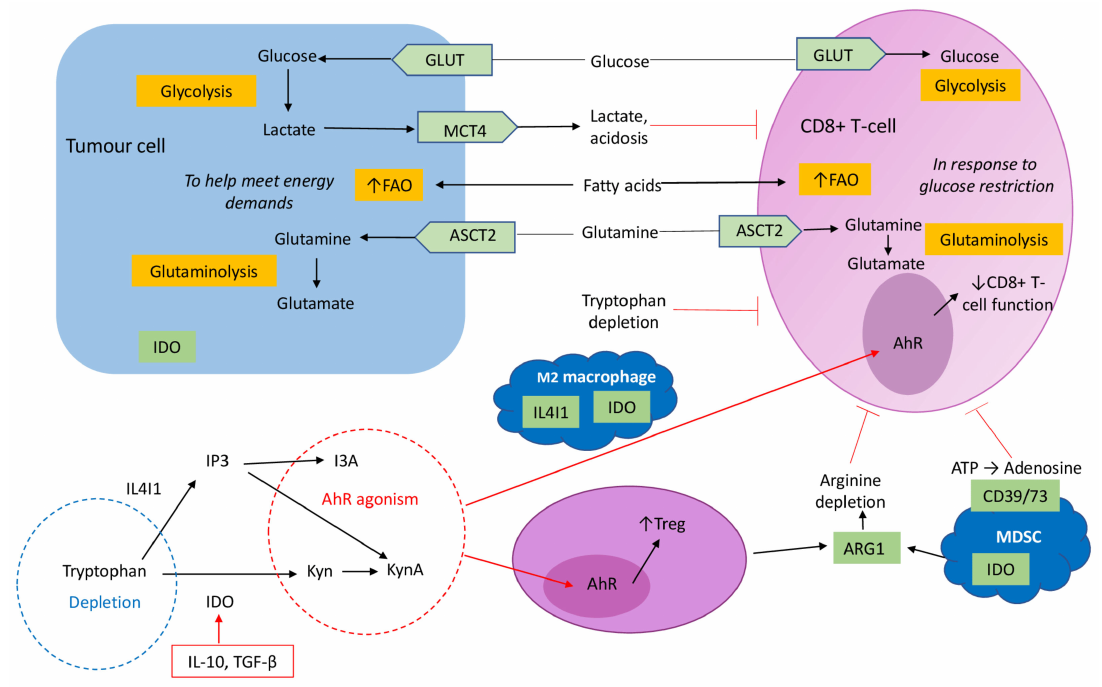
Figure 1. Effect of metabolic changes in the tumour microenvironment (TME) on immune cell differentiation. Increased tumour aerobic glycolysis, supported by upregulation of GLUT-mediated glucose provision provides energy for rapidly dividing cancer cells and leads to lactate accumulation within the TME. Fatty acid oxidation (FAO) is also utilised by tumour cells to supply energy for growth such that CD8+ T-cells starved of glucose increase FAO. Cancer cells also enhance amino acid metabolism to fulfil the energetic demands of rapid growth. Glutamine metabolism provides intermediates for the tricarboxylic acid cycle and maintains intracellular redox balance, making glutamine key to supporting cancer cell proliferation. This depletes glutamine from the TME, limiting its availability to CD8+ T-cells. Increased arginase 1 (ARG1) production by Tregs and MDSCs also limits arginine supply for CD8+ T-cell function. Cancer cell and M2 macrophage indolamine 2,3-dioxygenase (IDO) expression instead causes tryptophan depletion, which arrests CD8+ T-cell proliferation and upregulates regulatory T-cell (Treg) expansion. Tryptophan metabolism by IDO and IL4I1 yield the metabolites kynurenine (kyn), kynurenic acid (kyn A) and the indole I3a (indole-3-carboxaldehyde). Kyn and Kyn A are both ligands of the AhR receptor, which promote Treg differentiation and suppresses CD8+ T-cell function. Tumour transforming growth factor (TGF)- β induces upregulation of CD39/CD73 on MDSCs. These ectoenzymes hydrolyse adenosine triphosphate (ATP) to produce extracellular adenosine within the TME, which inhibits CD8+ T-cell proliferation. Abbreviations: GLUT: glucose transporters; MCT4: monocarboxylate transporter 4; ASCT2: glutamine transporter; IL-2/10: interleukin-2/10; TGF- β : transforming growth factor- β ; IP3: indole-3-propionic acid; I3a: indole-3-carboxaldehyde; IL4I1: L-amino acid oxidase